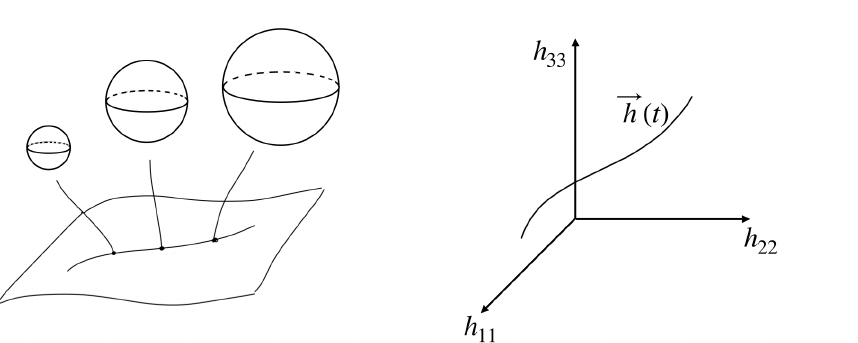
Figure 2. Left: the evolution of the universe can be seen as a path in the abstract space spanned by the component of the spatial metric tensor, h ab . Right: an example of evolution is depicted for the case that the spatial metric is diagonal, i.e., given by, h ab ( t ) = diag ( h 11 ( t ) , h 22 ( t ) , h 33 ( t ))